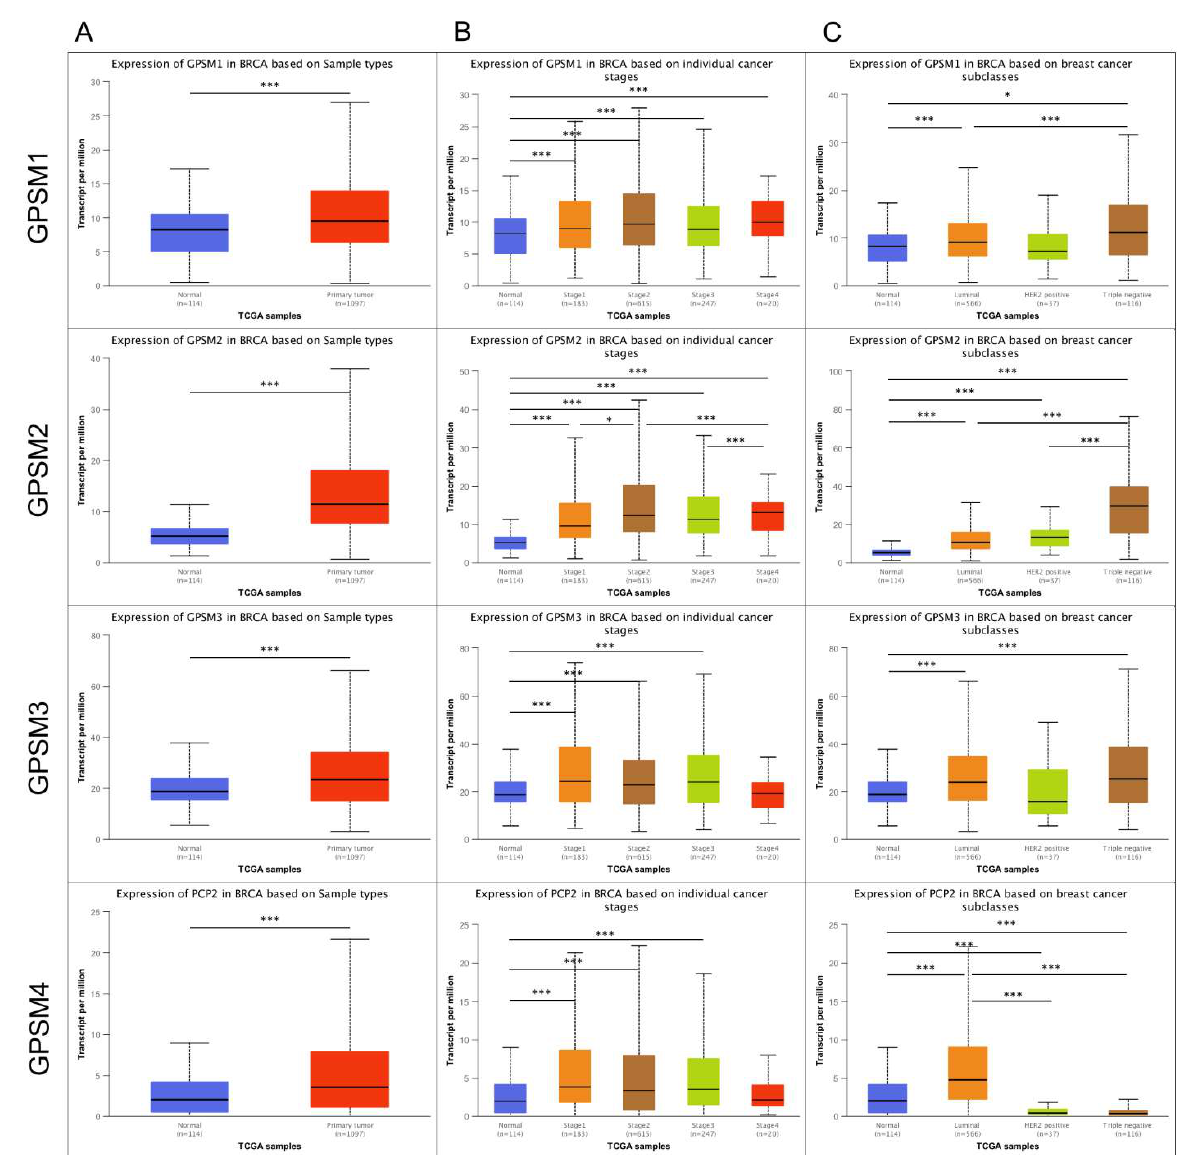
Figure 3. GPSMs expression in subgroups of people with breast cancer (UALCAN). Boxplots showing GPSMs transcript levels ( A ) in healthy controls versus individuals with breast cancer, ( B ) based on breast cancer stages, and ( C ) based on breast cancer subclasses. (* p < 0.05; *** p < 0.001).